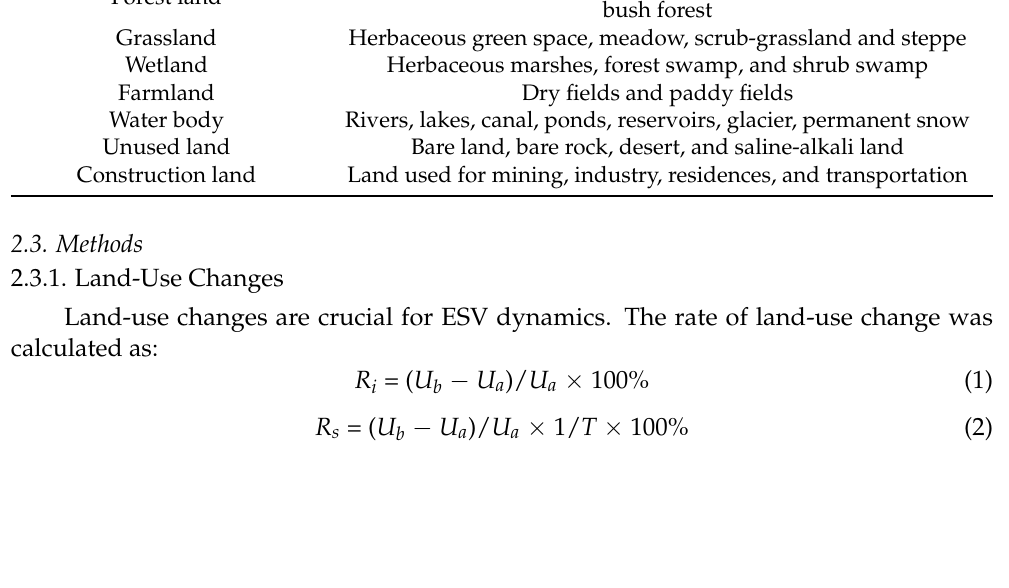
Table 1. Land-use types in the national nature reserves of western China. Type Concrete Arbor, broad-leaved forest, coniferous forest, mixed forest, and Forest land bush forest Grassland Herbaceous green space, meadow, scrub-grassland and steppe Wetland Herbaceous marshes, forest swamp, and shrub swamp Farmland Dry fields and paddy fields Water body Rivers, lakes, canal, ponds, reservoirs, glacier, permanent snow Unused land Bare land, bare rock, desert, and saline-alkali land Construction